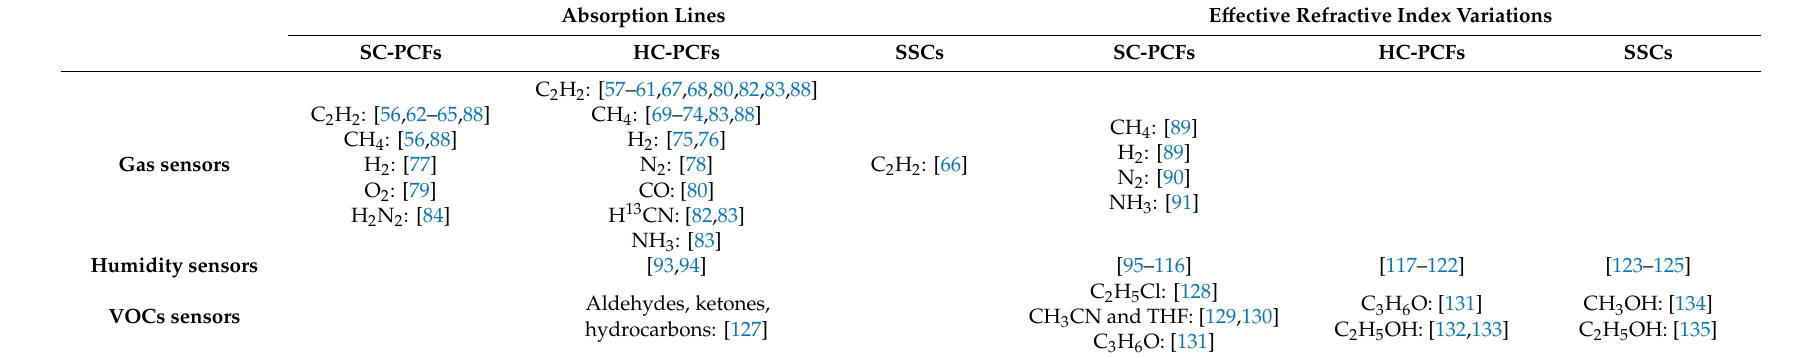
Table 5. Summary table of every sensor cited and explained in this review grouped by parameter detected and MOFs